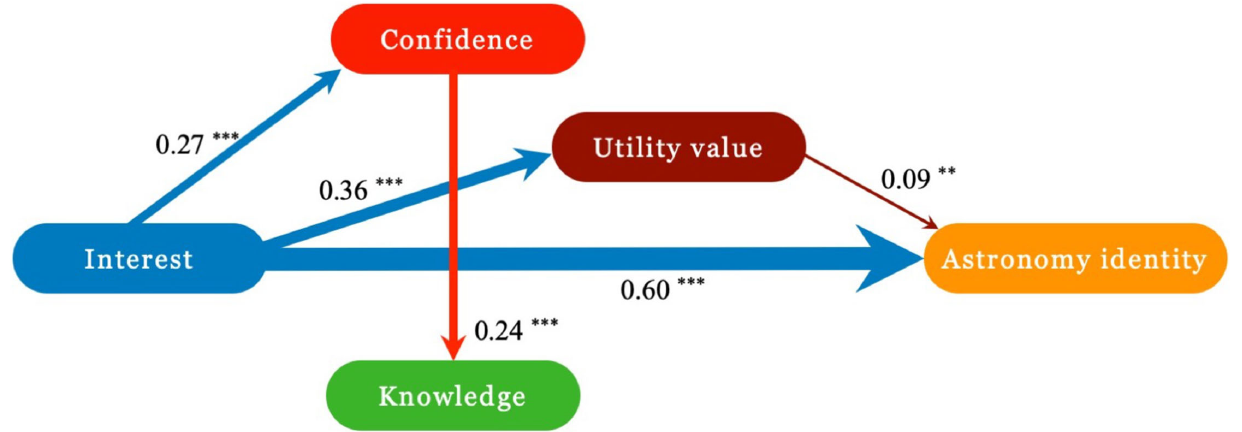
FIG. 3. Structural model of astronomy identity. Regression weights are standardized. Each arrow with the line connecting two variables in the diagram indicates the direction of regression. ** p < 0 . 01 ; *** p < 0 . 001